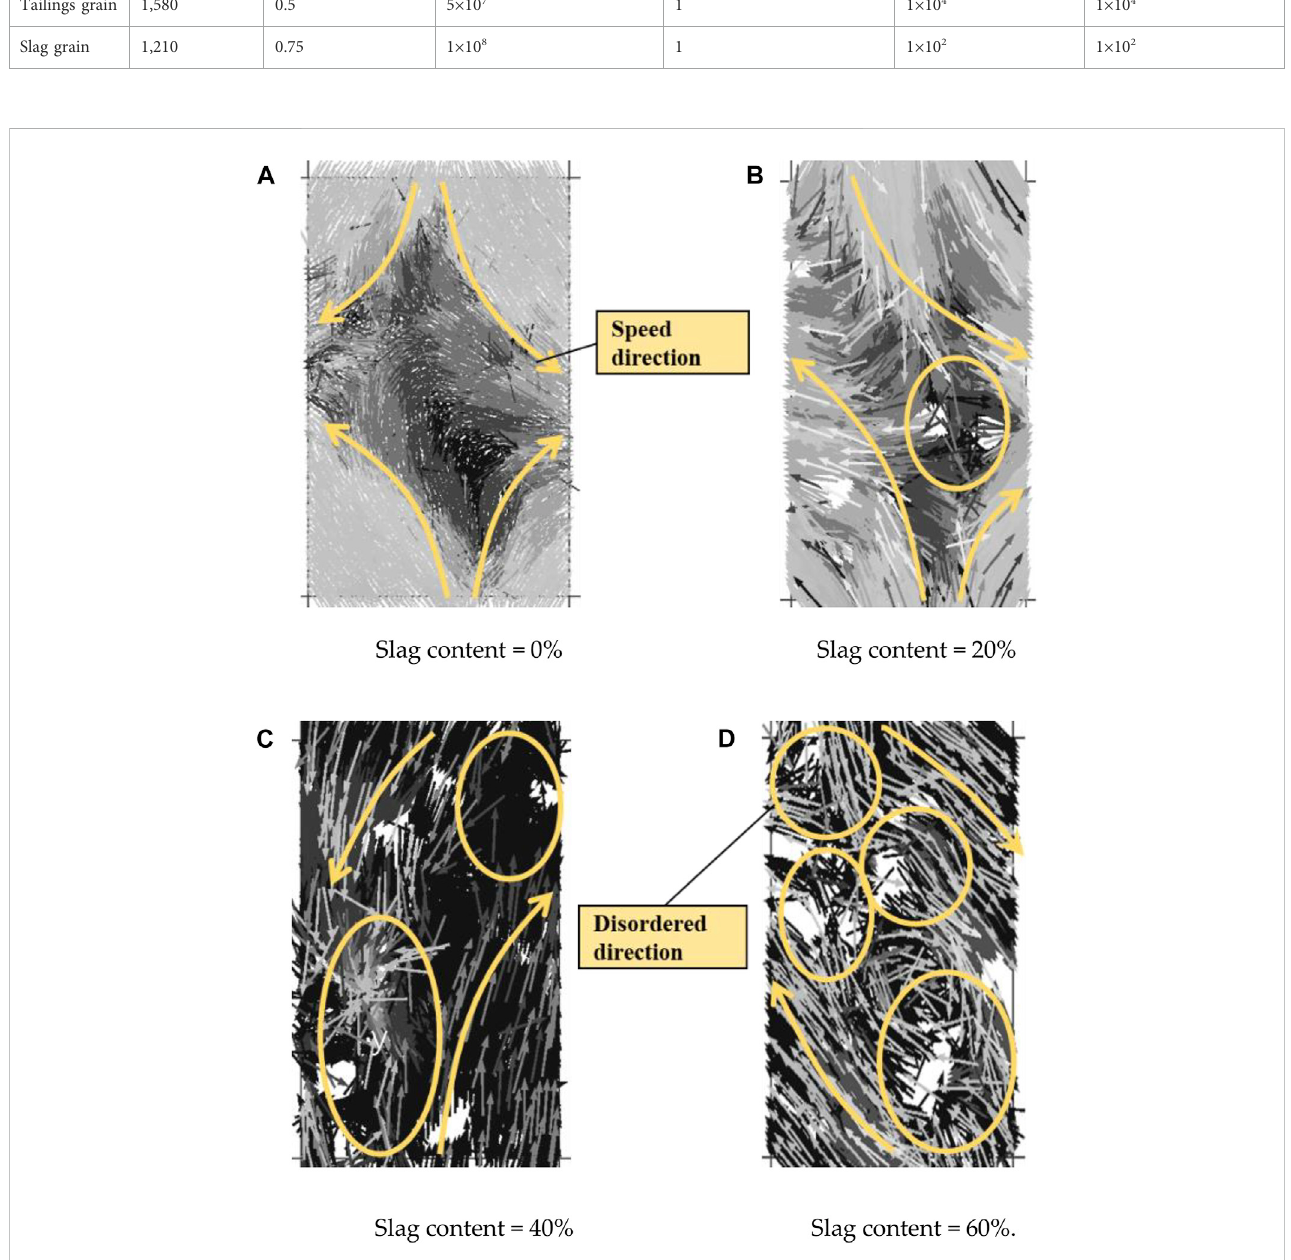
FIGURE 9 The vector plot of particle velocities for the con fi ning pressure of300 kPa: (A) slag content = 0%, (B) slag content = 20%, (C) slag content= 40%, and (D) slag content = 60%.